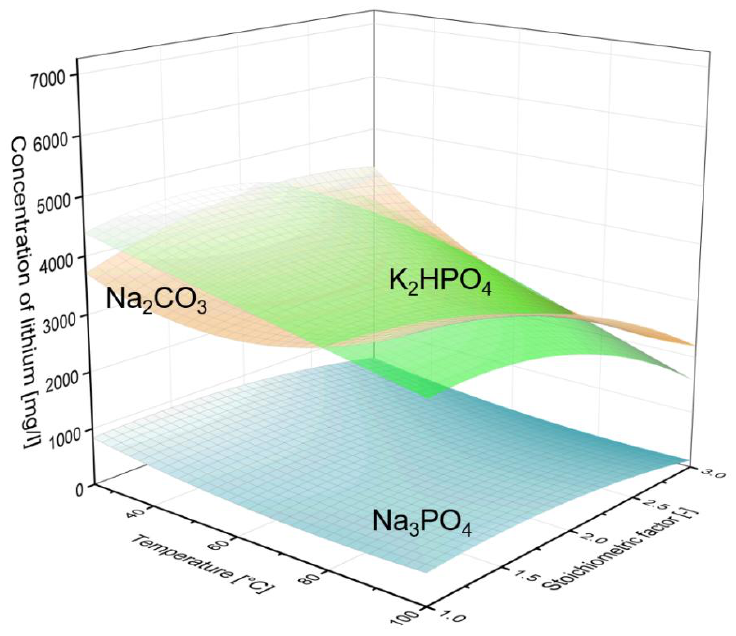
Figure 11. Comparison of the precipitants Na 3 PO 4 , K 2 HPO 4 and Na 2 CO 3 based on the authentic leaching solution from lithium ion batteries (5000 mg · L − 1 ) as a function of temperature and the stoi- chiometric factor of the precipitant.